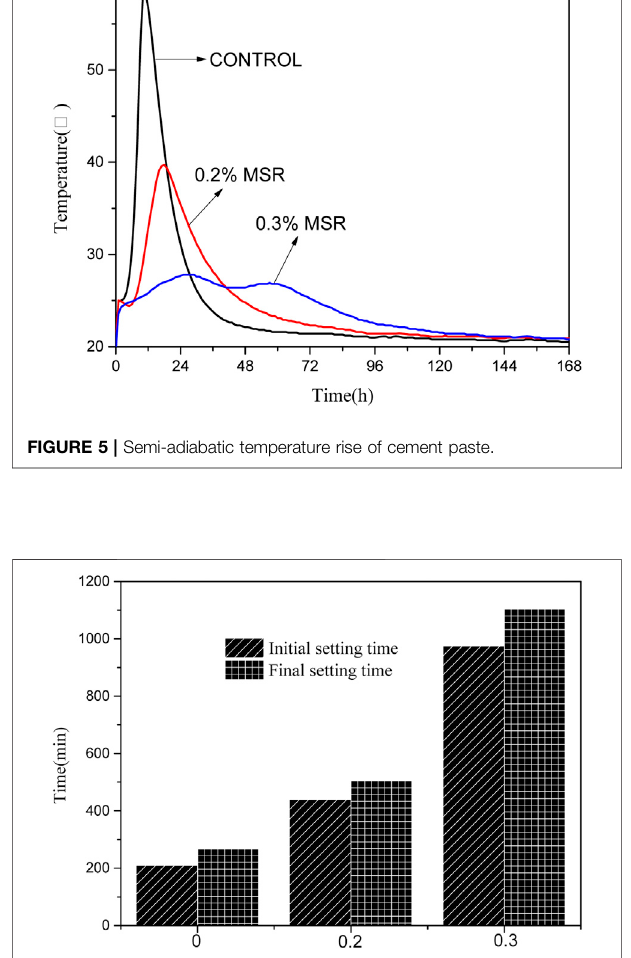
Frontiers in Materials |